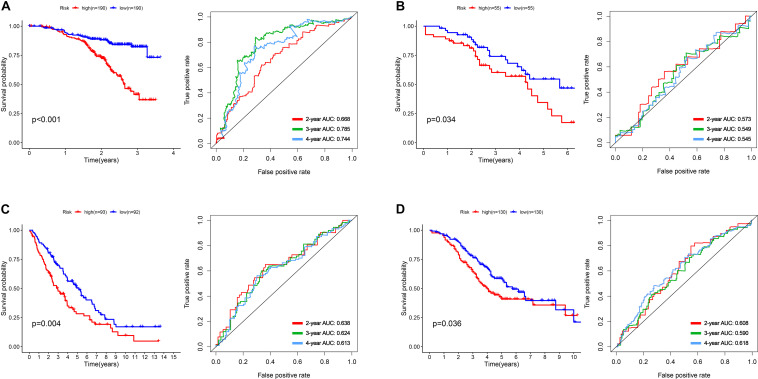
The development and validation of the five-mRNA signature. (A) Kaplan-Meier analysis and ROC curves of overall survival in the high- and low-risk groups of OC patients in the GSE140082 dataset. (B) Kaplan-Meier analysis and ROC curves of overall survival in the high- and low-risk groups of OC patients in the GSE17260 dataset. (C) Kaplan-Meier analysis and ROC curves of overall survival in the high- and low-risk groups of OC patients in the GSE 26712 dataset. (D) Kaplan-Meier analysis and ROC curves of overall survival in the high- and low-risk groups of OC patients in the GSE32062 dataset.